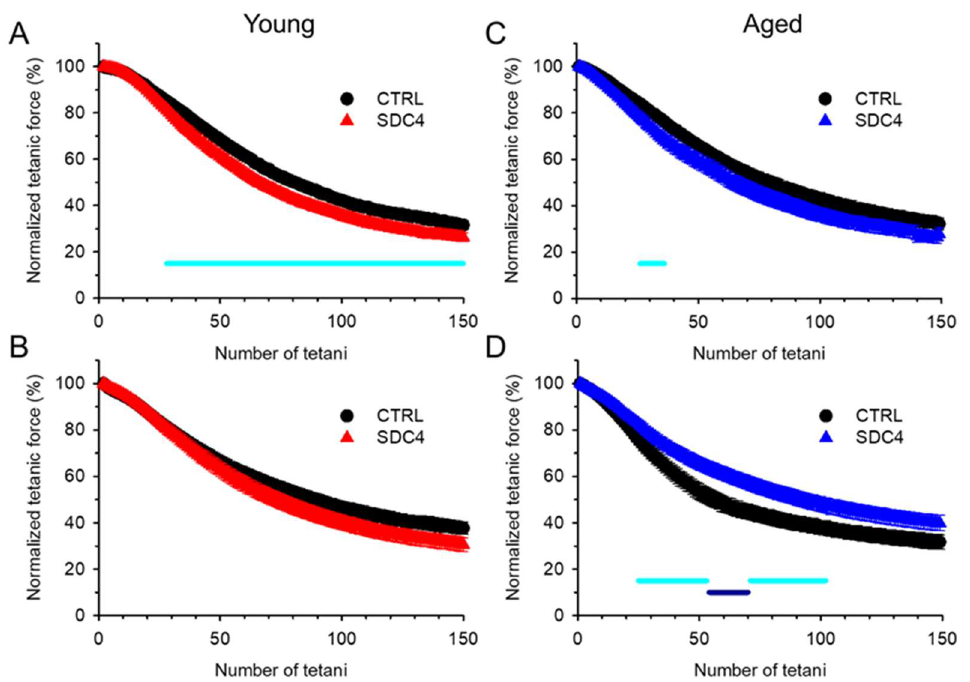
Figure 3. Ex vivo fatigue of EDL ( A , C ) and SOL ( B , D ) muscles from young ( A , B ) and aged ( C , D ) CTRL (black circle) and SDC4 (red and blue triangle) mice. The protocol contained 150 consecutive tetani. All tetani were normalized to the first one. The numbers of animals and muscles are the same as in Figures 1 and 2. The solid light-blue and dark-blue lines show the intervals where the difference is significant between the CTRL and SDC4 mice at p < 0.05 and p < 0.01, respectively.